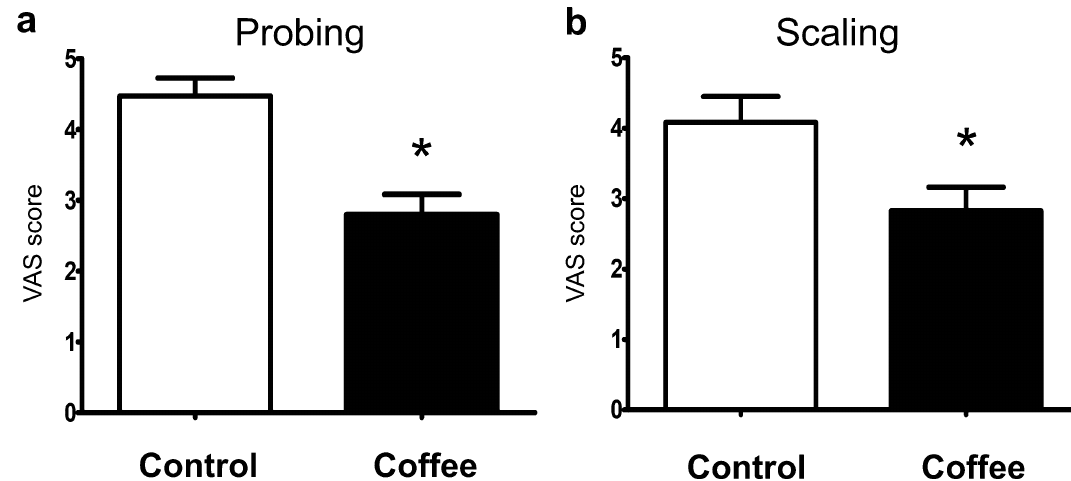
Figure 3. The mean scores of VAS after probing ( a ) and scaling ( b ) in control and coffee groups. p <